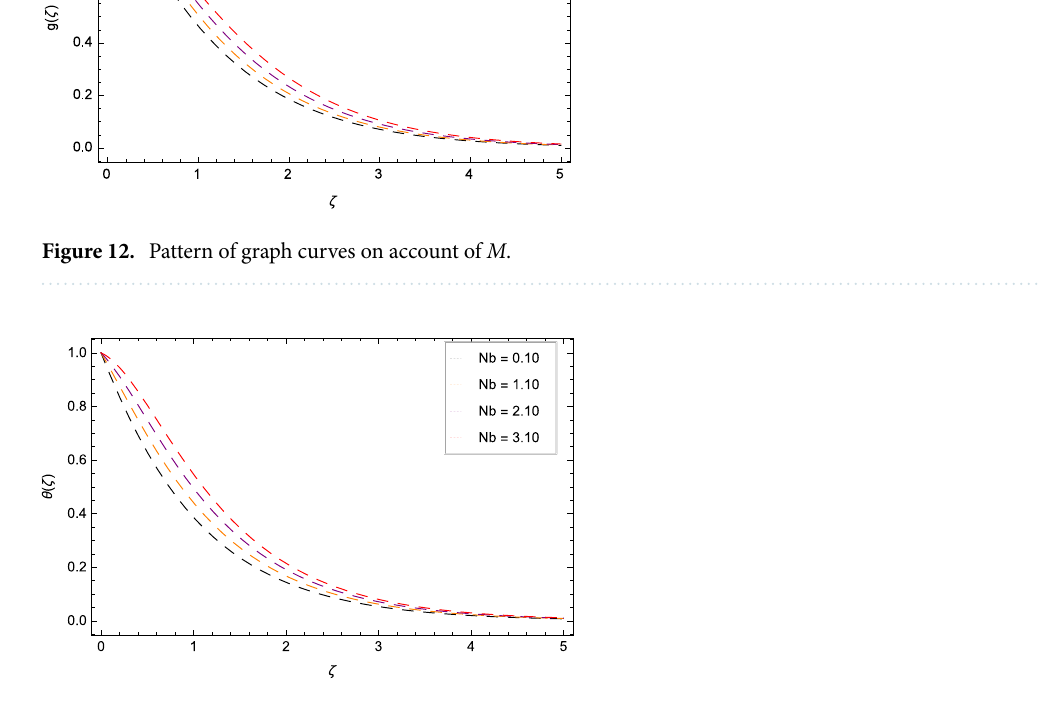
Figure 13. Pattern of graph curves on account of Nb